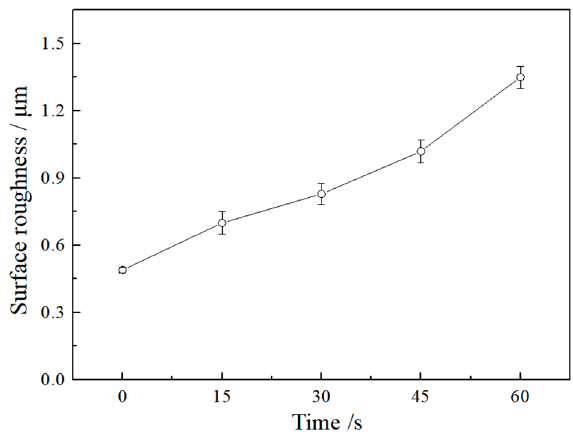
Figure 3. Surface roughness of Al-12 Si by different etching treatment time.